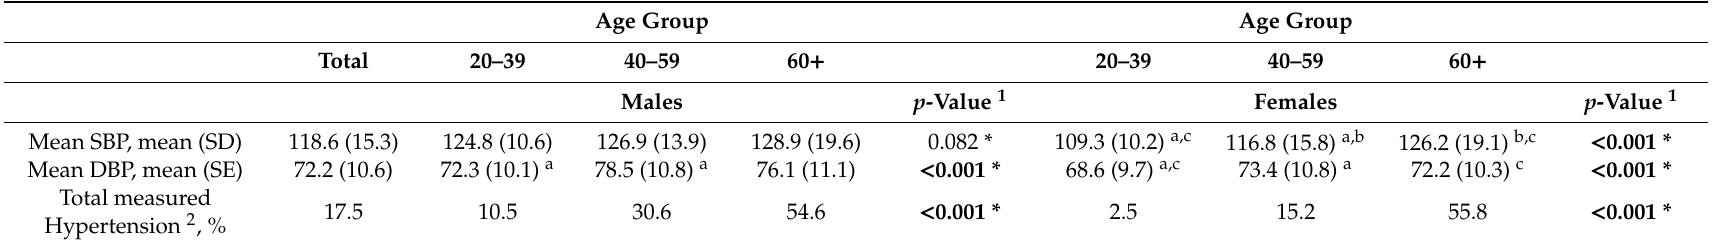
Table 2. Percentage distribution of blood pressure level in the adult Greek population by sex and age